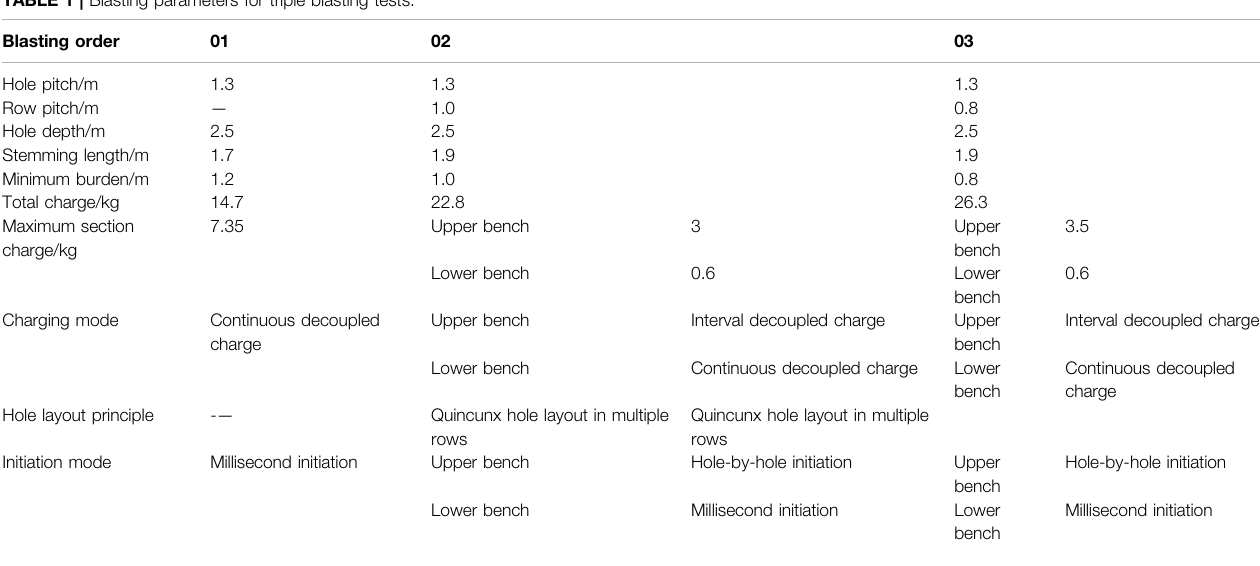
TABLE 1 | Blasting parameters for triple blasting tests.